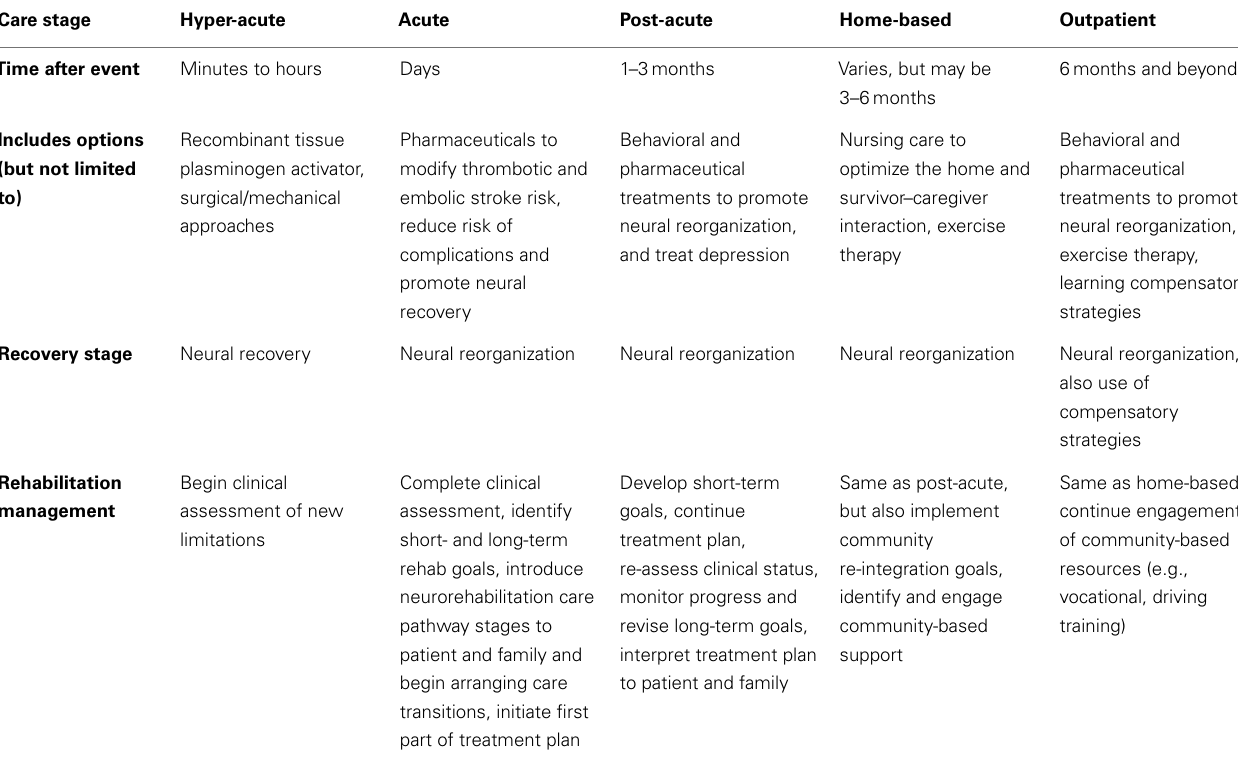
Table 1 | Brief outline of care pathway for neurorehabilitation after stroke,Adapted from Ref. (20, 21). Care